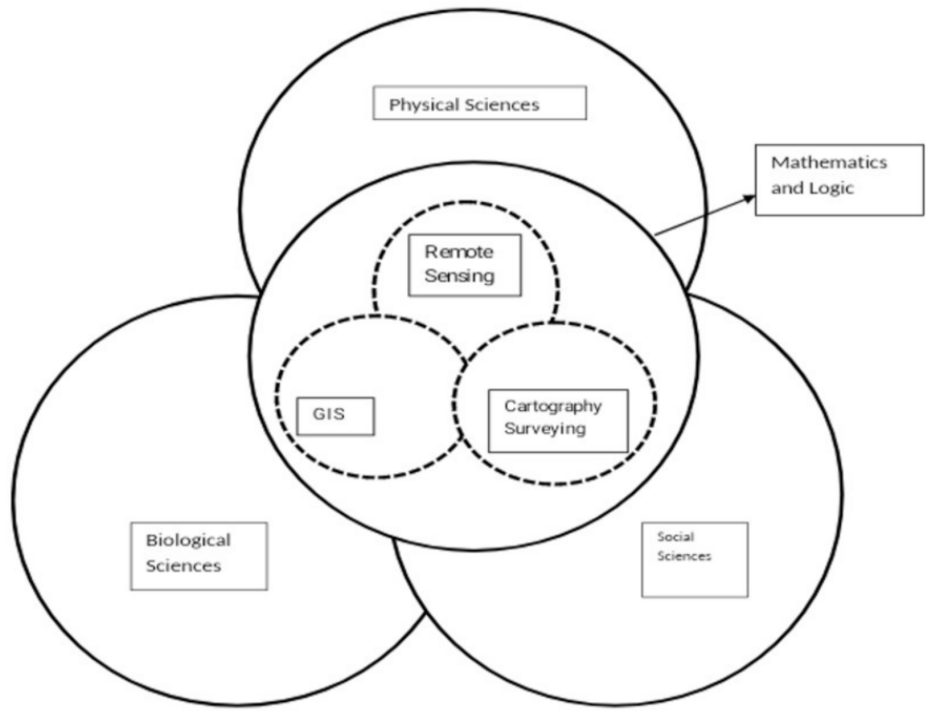
Figure 1. An interaction model depicting the relationship of remote sensing with the social, physical, and biological sciences and with mathematics and logic.